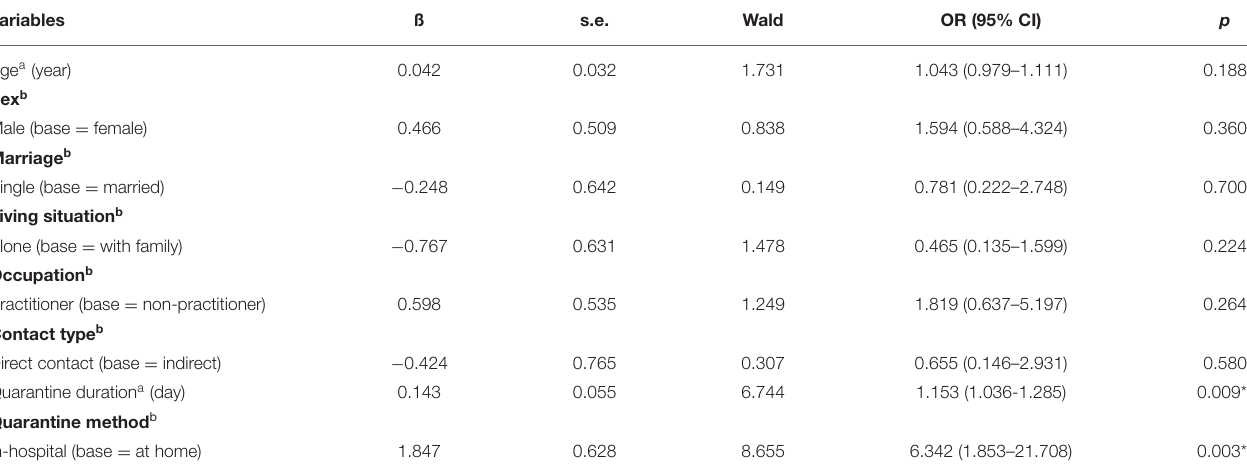
TABLE 3 | Variables that affect presence of depressive